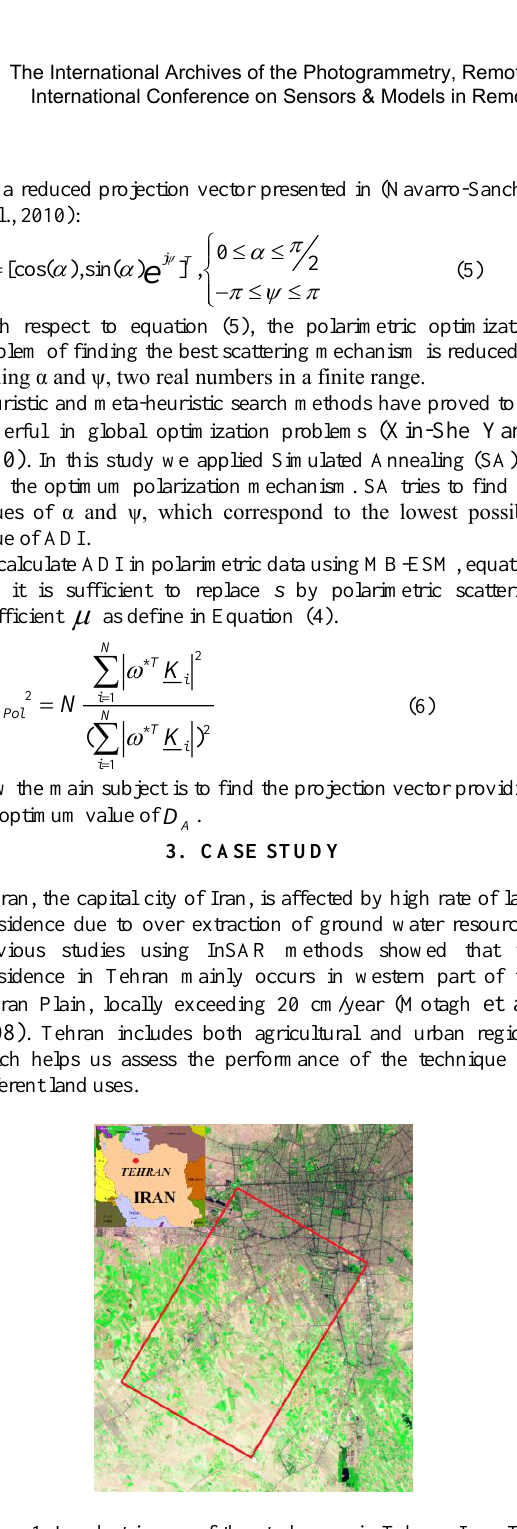
Figure 1. Landsat image of the study area in Tehran, Iran. The red rectangle shows the outline of the cropped TSX images used in this study. The inset in the upper left shows the location of Tehran in Iran.